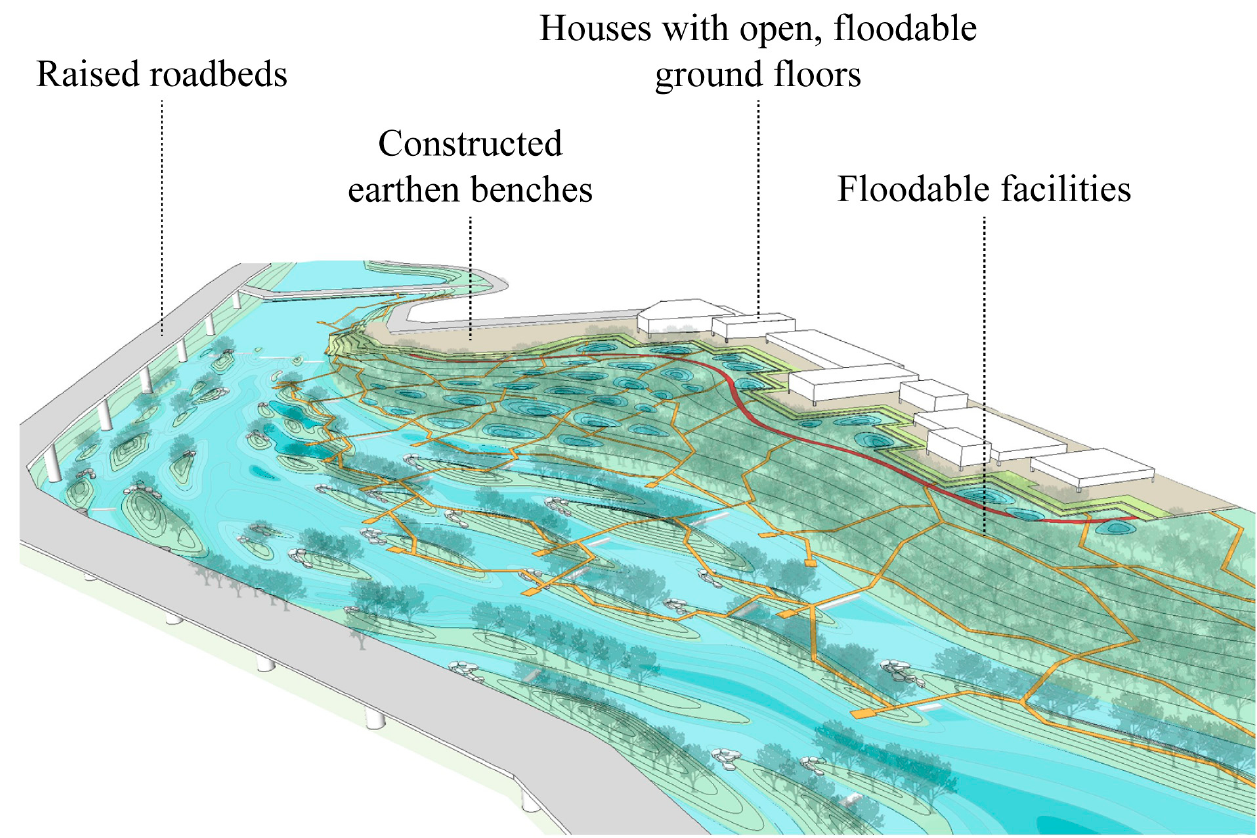
Figure 4. Sink strategies include constructing earthen benches atop which future construction can take place, building houses with open, floodable ground floors and raising roadbeds, employing floodable facilities in riparian areas, and so on.